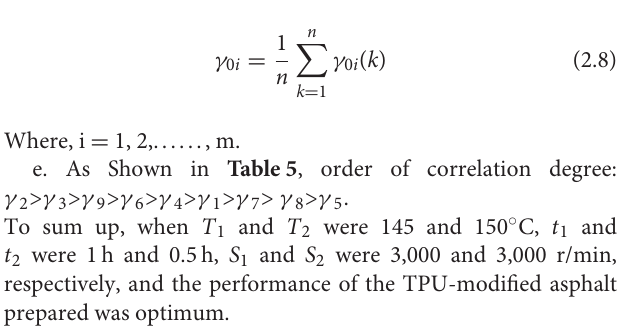
TABLE 3 | Making indexes dimensionless.